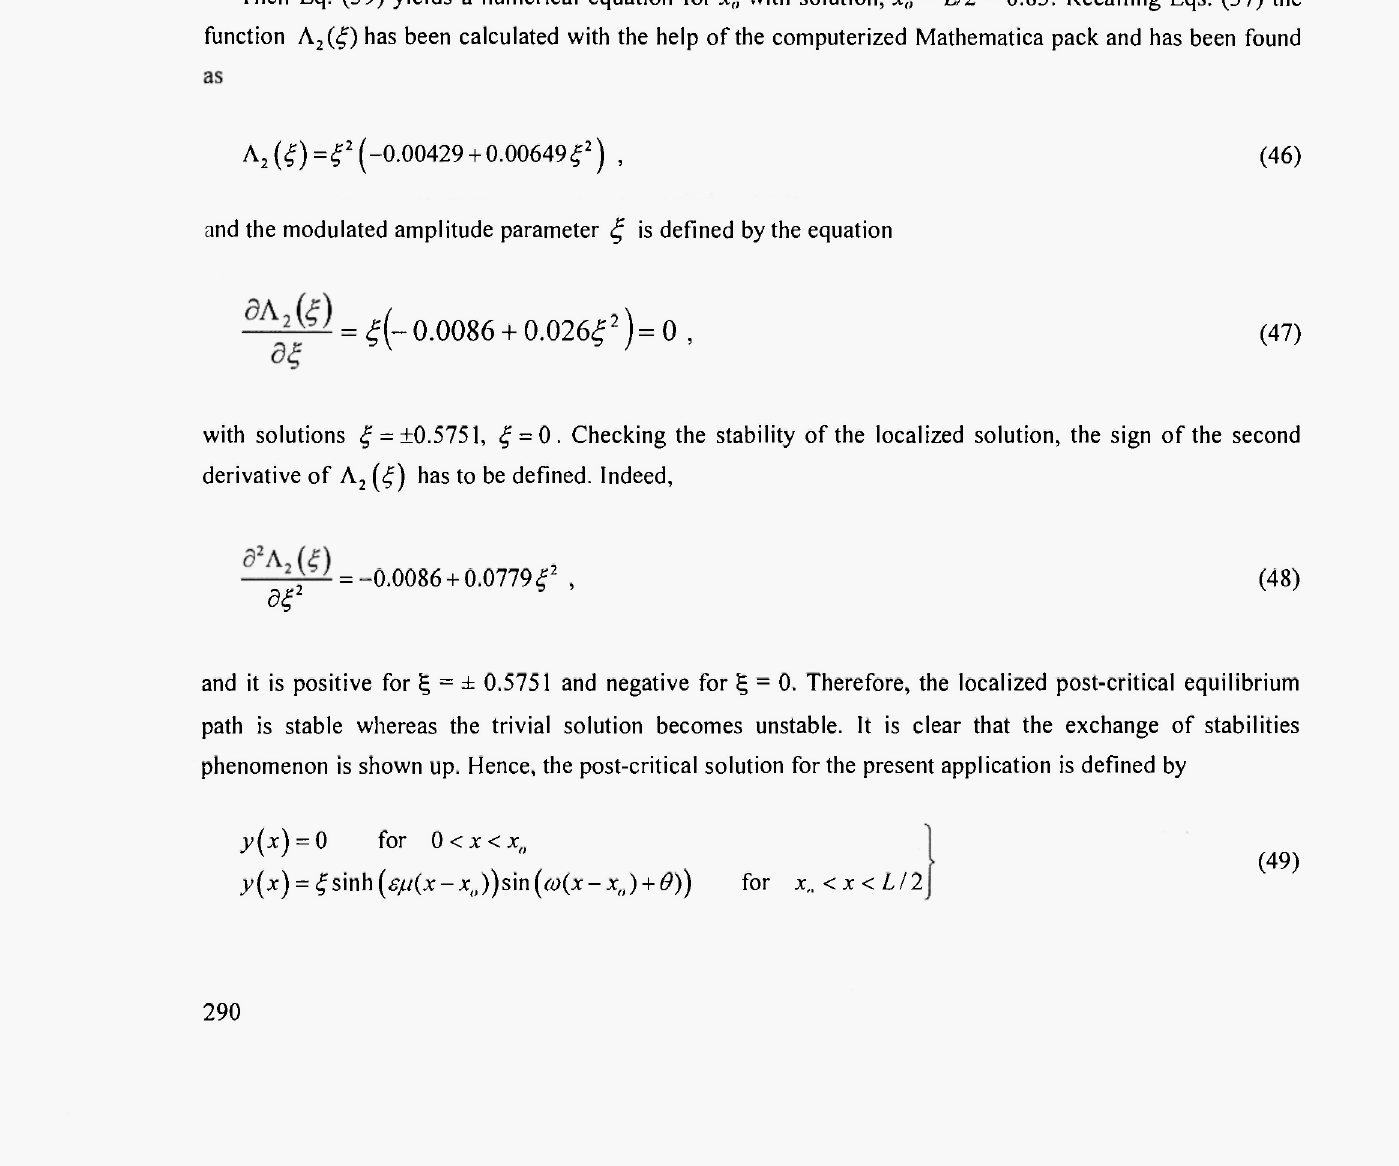
Fig.3: The function A,